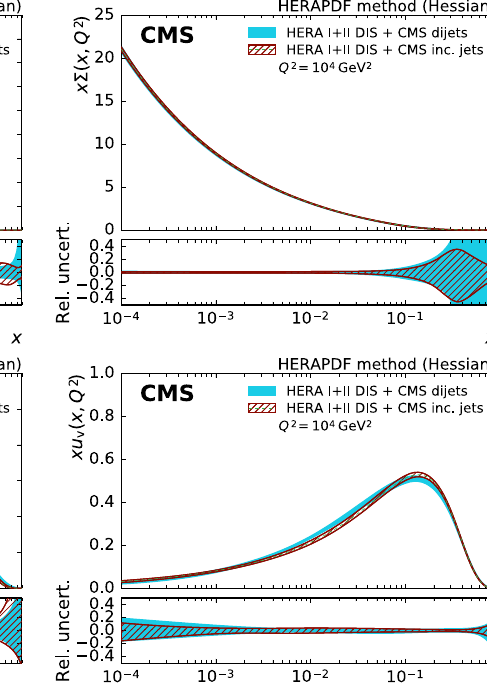
with CMS inclusive jet data (solid band) and CMS dijet data (hatched band) at 8 TeV. The PDFs are shown at the scale Q 2 = 10 4 GeV 2 with their total